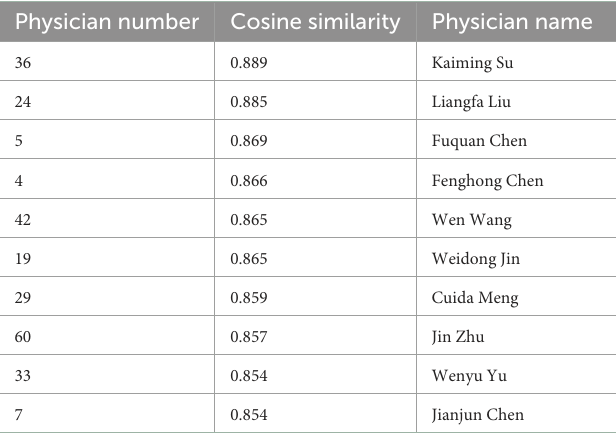
TABLE 13 Recommended results based the similar patients and similar